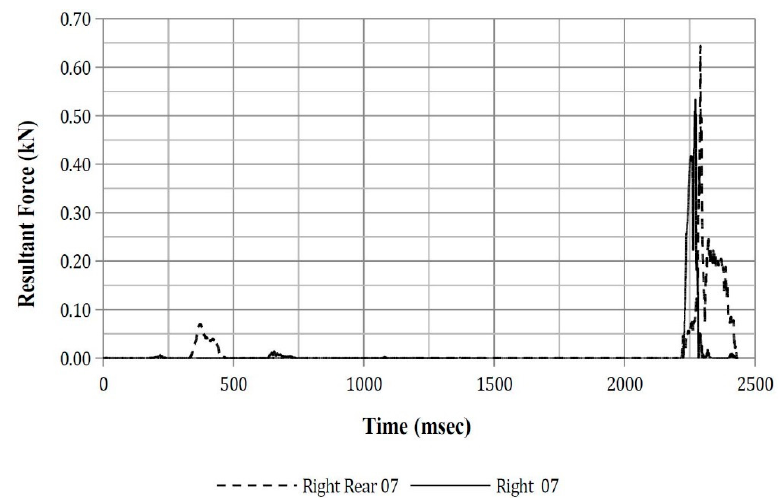
Figure A29. ATD Position 8 thorax resultant force.